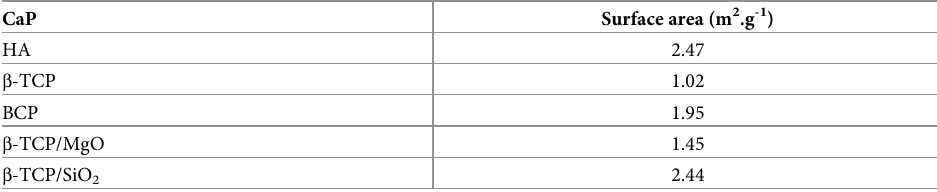
Table 1. The initial surface area of the calcium phosphate (CaP) biomaterials.